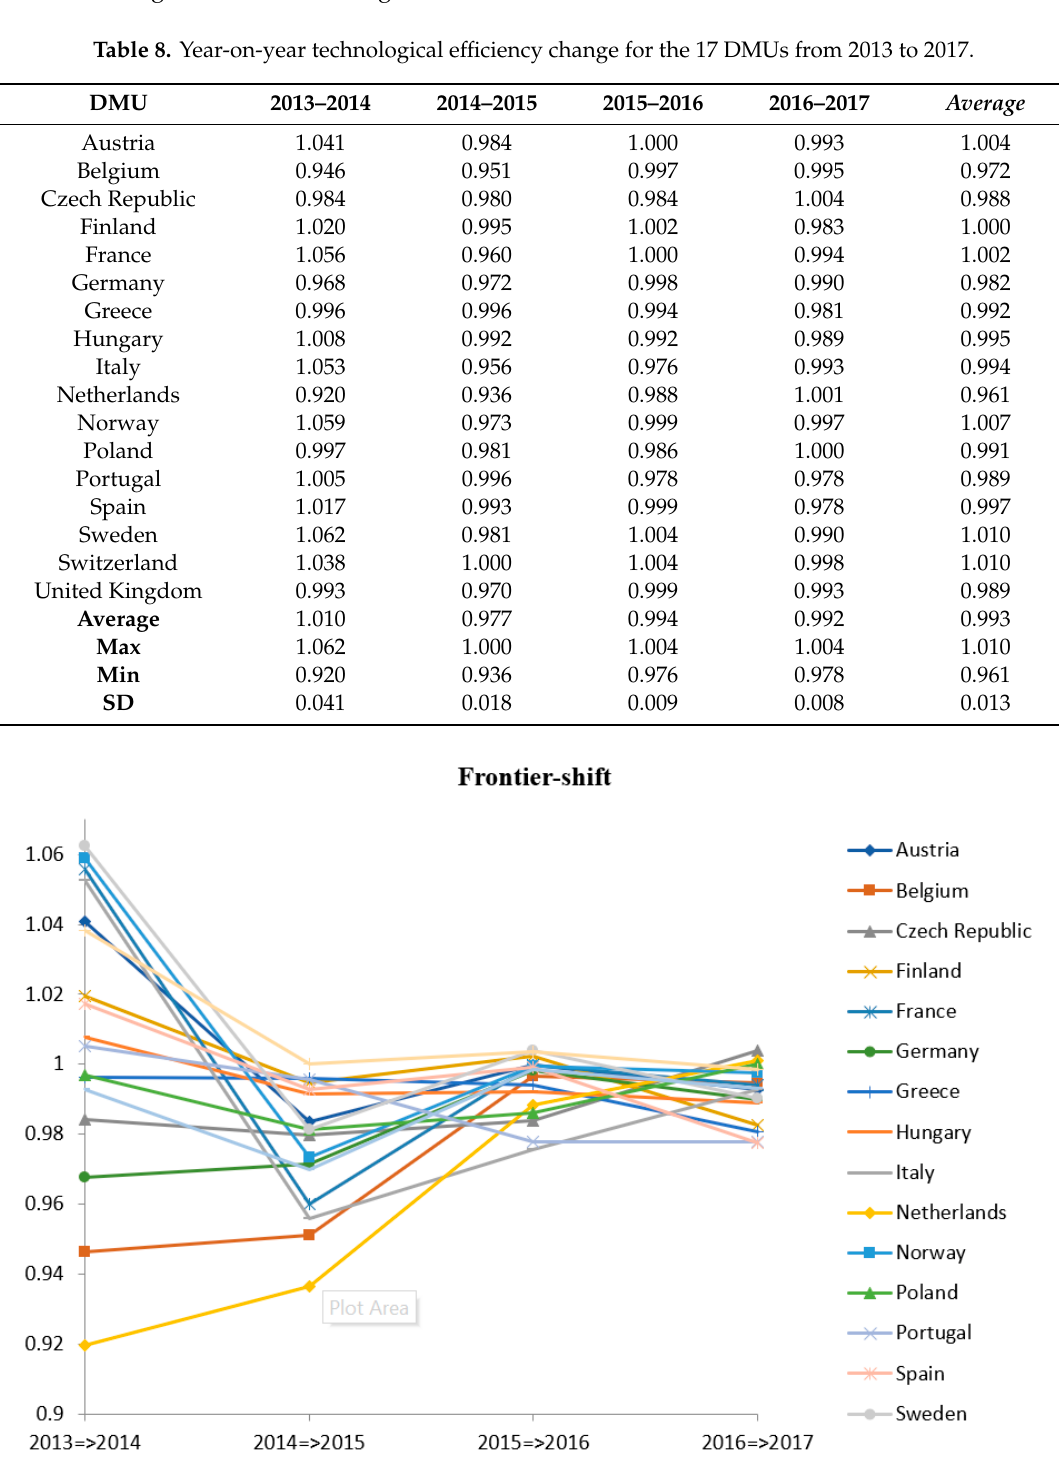
Figure 3. Yearly technological changes from 2013 to 2017.